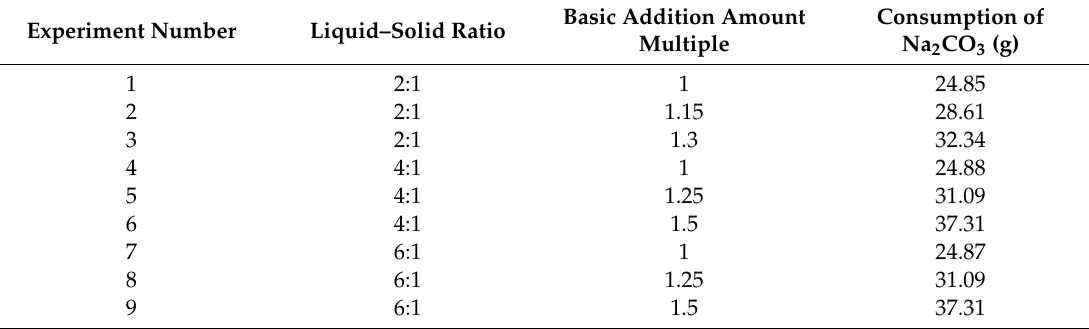
Table 3. Experimental scheme of RHF secondary dust saturated alkali